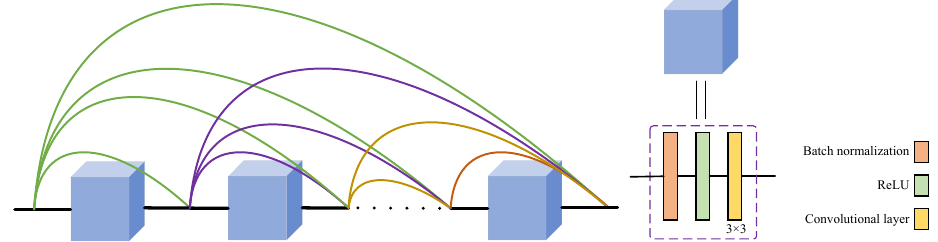
Figure 2. Densely connected convolutional block of